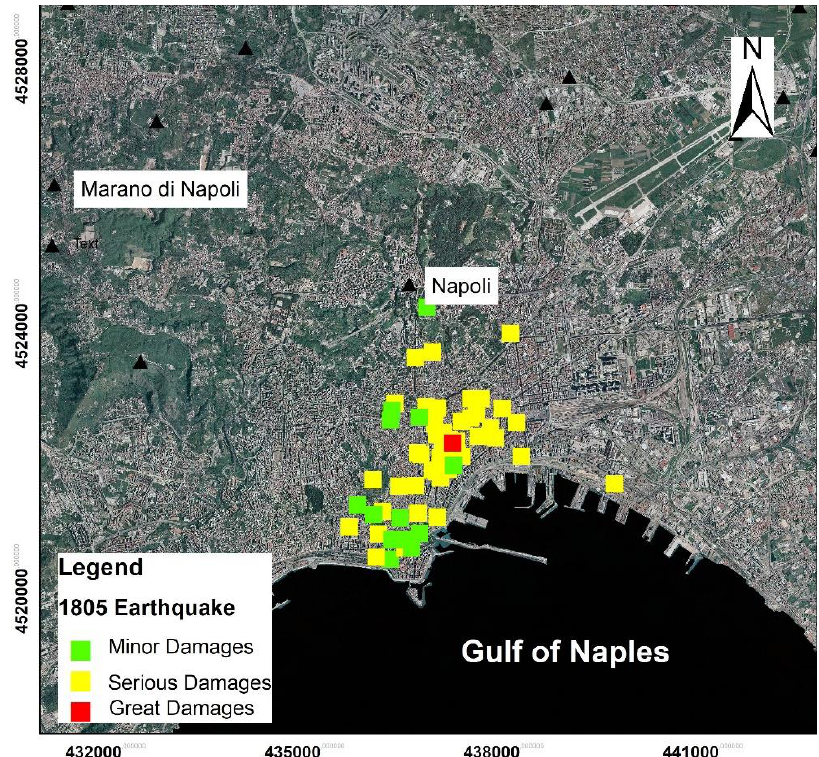
Figure 8. Map of damages caused in Naples by the 26 July 1805 earthquake.